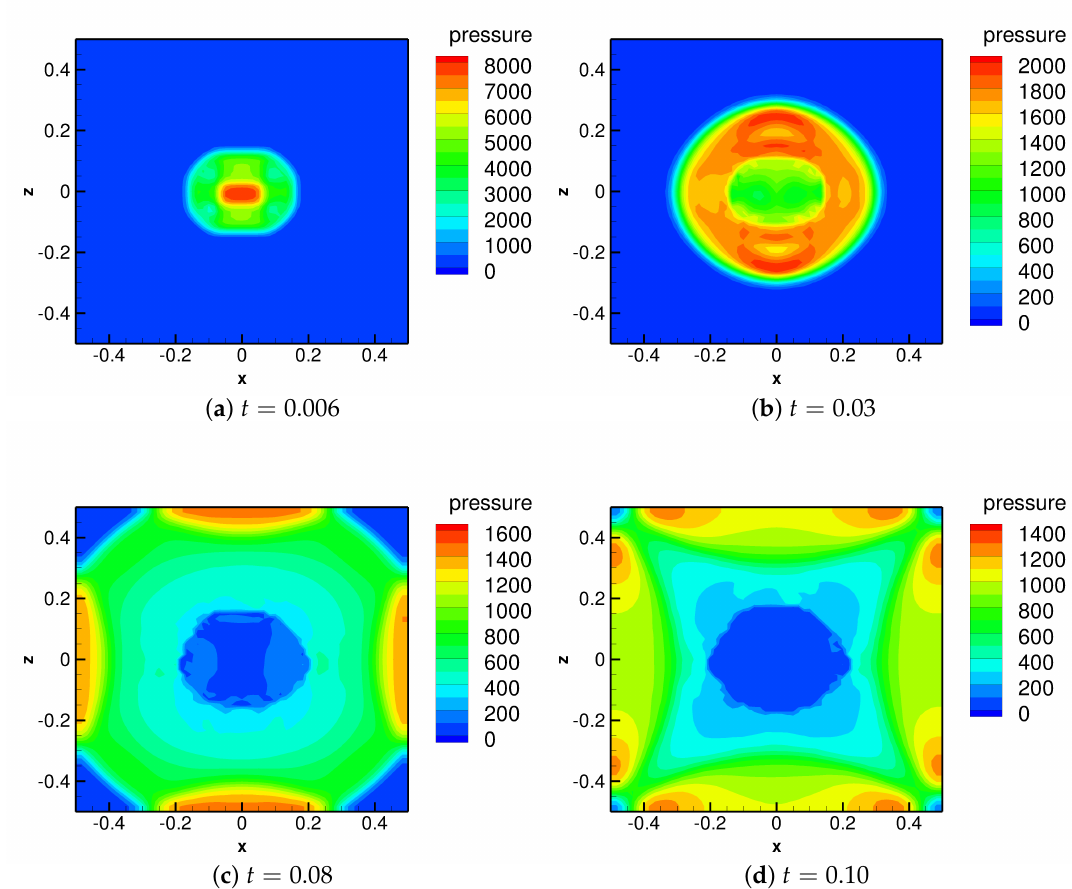
Figure 5. The temporal evolution of the pressure field for an initially cylindrical bubble in slice plots ( y = 0.0). Note that the range of the legend in each figure is different for a better